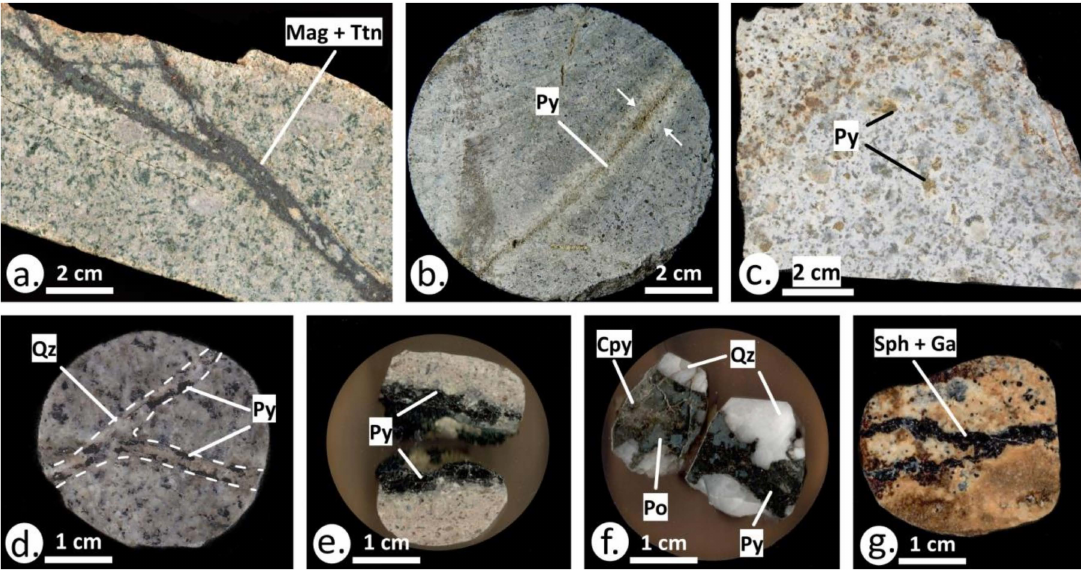
Figure 3. Mineralization stages from the Vathi porphyry Cu-Au-(Mo) system. ( a ) Magnetite (Mag) and titanite (Ttn) in M-type vein crosscutting a quartz monzonite surface sample (potassic-calcic alteration); ( b ) pyrite (Py) in A-type vein crosscutting quartz monzonite drill core sample (potassic overprinted by sericitic alteration). A distinctive hydrothermal halo envelopes the vein (white arrows); ( c ) disseminations and aggregates of pyrite (Py) in a latite surface sample (sericitic alteration); ( d ) quartz (Qz) and pyrite (Py) in a D-type vein from a quartz monzonite surface sample (sericitic alteration); ( e ) pyrite (Py) in D-type vein from a latite drill core sample (sericitic alteration); ( f ) pyrite (Py), pyrrhotite (Po), and